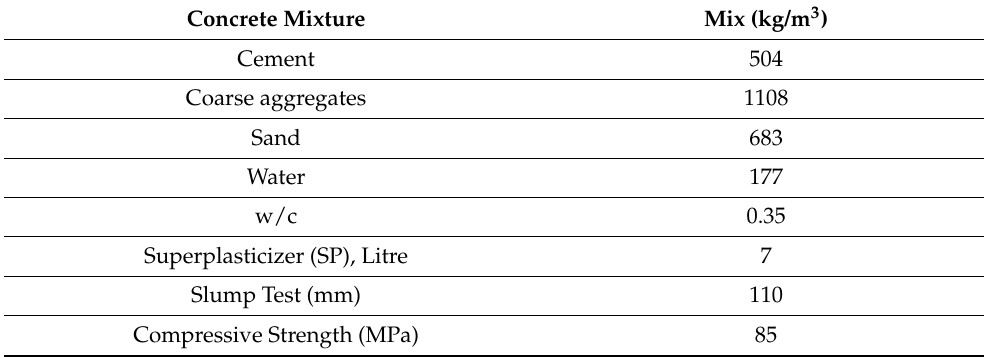
Table 2. The mixed proportions of plain concrete.